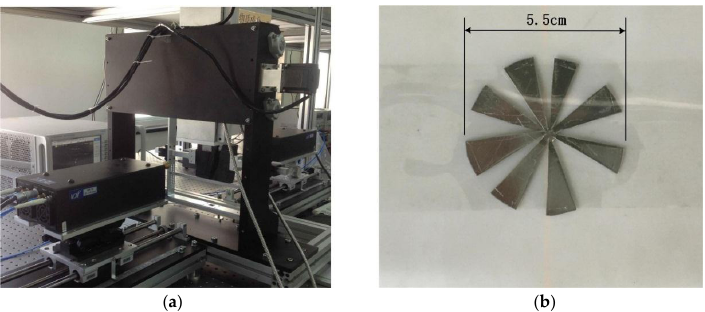
Figure 11. The setup of the experiment: ( a ) the experiment platform; ( b ) the sample to be imaged.